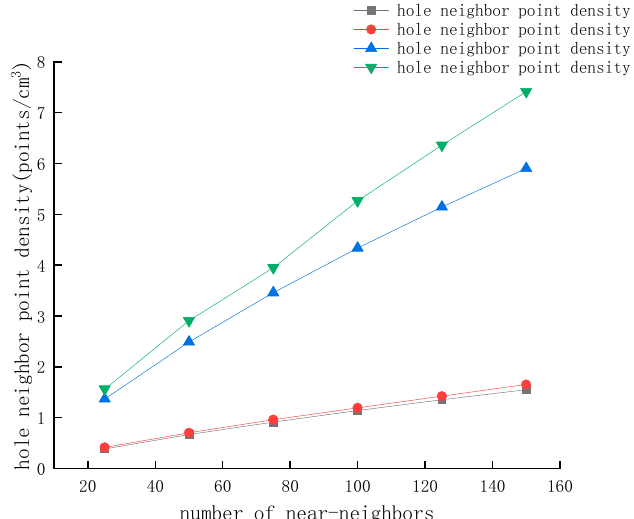
Figure 22. Point cloud density retrieved with different K values. ( a ) Point cloud density retrieved in hole a with different K values. ( b ) Point cloud density retrieved in hole b with different K values. ( c ) Point cloud density retrieved in hole c with different K values. ( d ) Point cloud density retrieved in hole d with different K values.